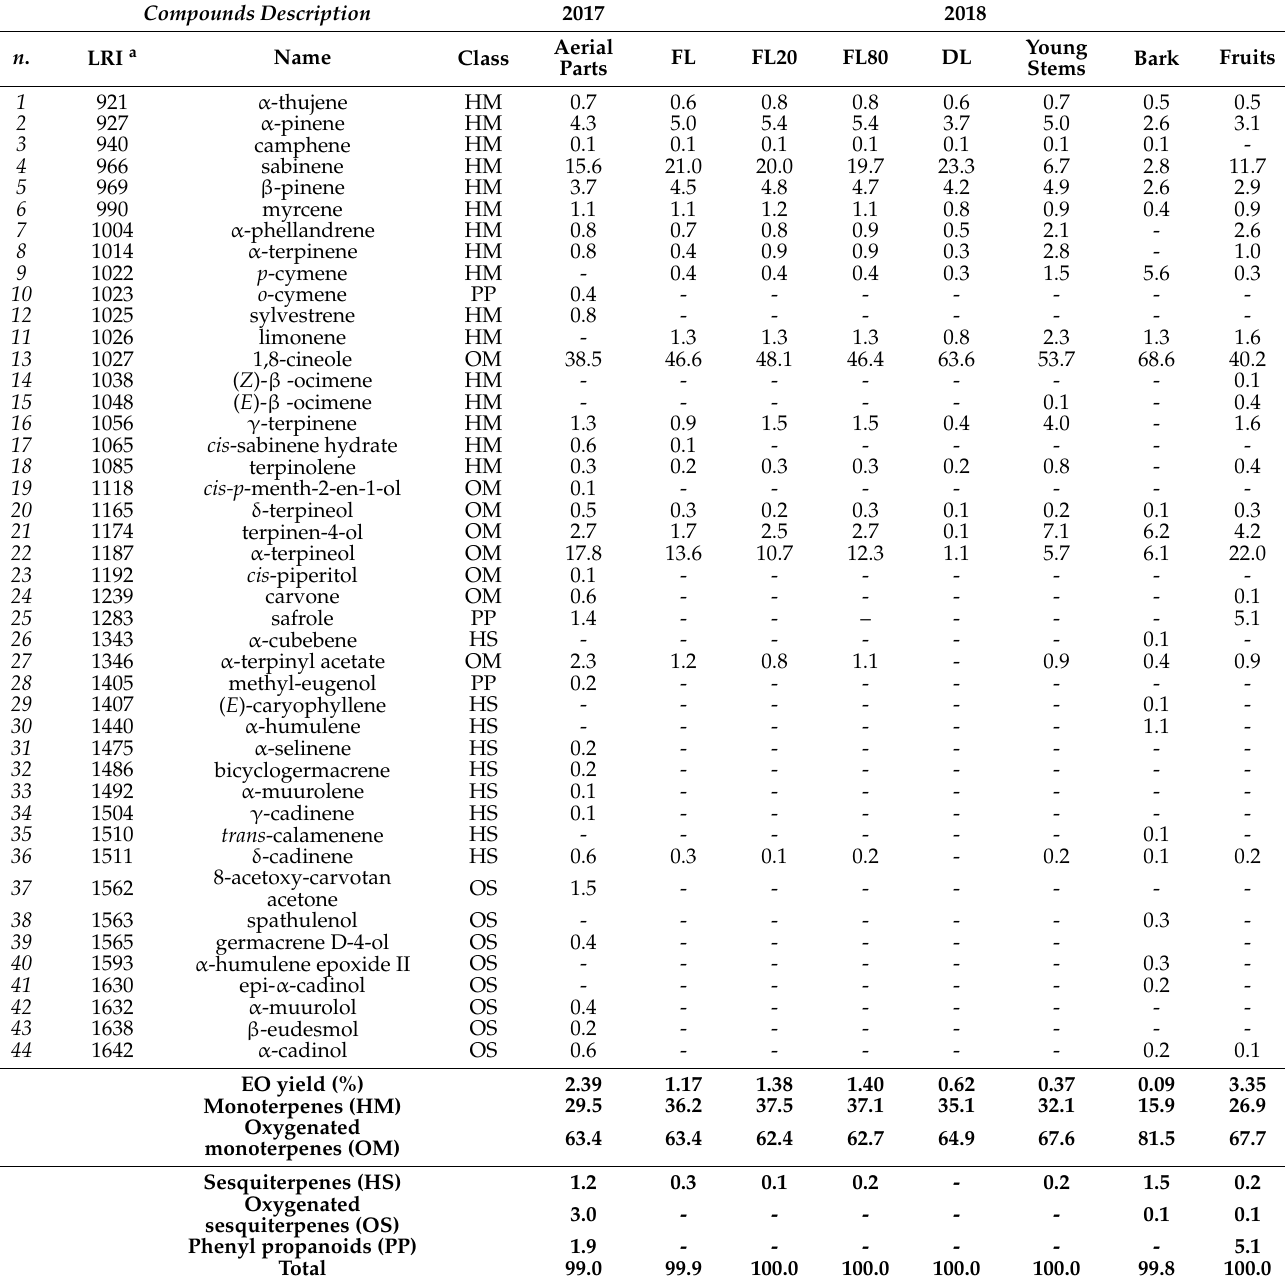
Table 2. Composition of the essential oils of C. camphora obtained in 2017 and 2018 from different plant parts and conservation procedures. FL , fresh leaves; FL20 , storage at − 20 ◦ C; FL80 , storage at − 80 ◦ C; DL , dried leaves. Data are reported as relative abundance